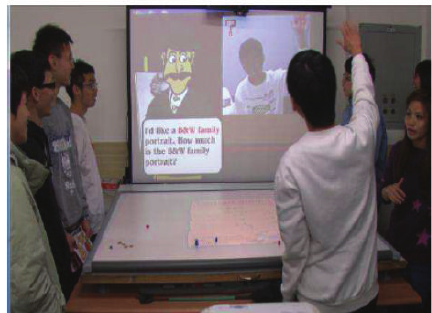
Figure 3: L-shape plate form [24].